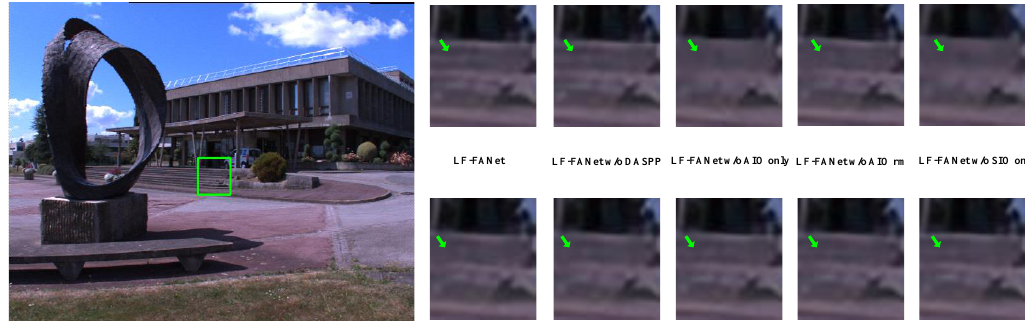
Figure 14. Visual ablation study